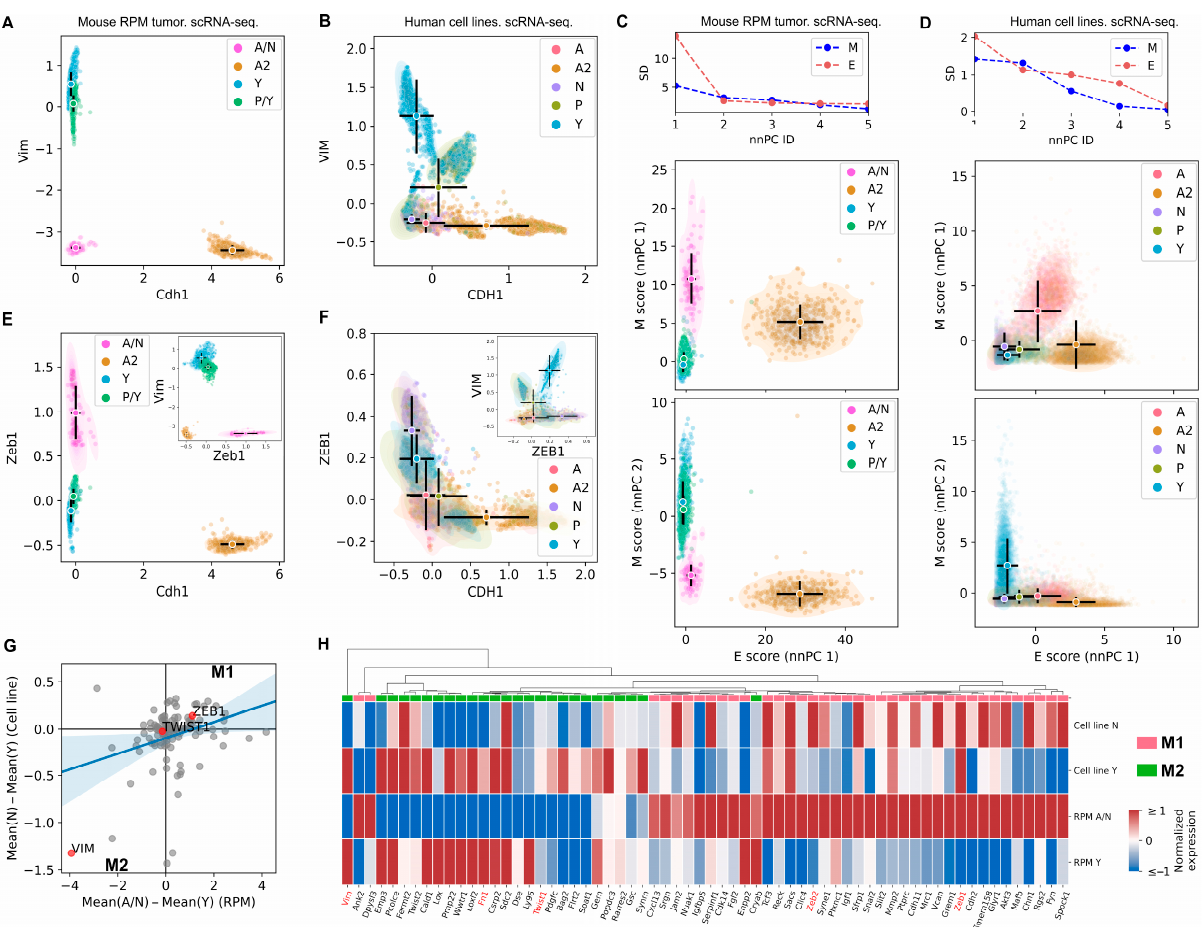
Figure 2. Divergence of mesenchymal gene expressions in SCLC subtypes. ( A , B ) Normalized expression levels of Vim (M gene) and Cdh1 (E gene) in 15,138 mouse Myc -driven tumor cells ( A ) and in 13,945 cells from eight SCLC cell lines ( B ). Imputed data were plotted in B for visual aid. Circles and black bars show means and standard deviations of SCLC subtypes. ( C , D ) Line plots: nnPCA was performed. Plots show standard deviations of SCLC subtype means for mouse and human SCLC cells from the top 5 PCs. Scatter plots: nnPCA-based E and M scores. ( E , F ) Normalized ex- pression levels of Zeb1 (M gene) and Cdh1 (E gene) in 15,138 mouse Myc -driven tumor cells ( E ) and in 13,945 cells from 8 SCLC cell lines ( F ). Imputed data were plotted in F for visual aid. ( G ) Mean differences between N cells (A/N cells for mouse) and Y cells in individual M gene’s expression in mouse and human SCLC cells. ( H ) A heatmap showing the diversity of M gene expression across N (A/N) and Y subtypes. 3.3. The Highly Epithelial A2 Subtype and Diverse M Gene Expression Patterns Are Detectable in Human SCLC Tumor The distinction between the A2 and A subtypes has generally not been considered in previous studies by other investigators. For example, Chan et al. profiled 54,523 individ- ual SCLC cells from 19 human samples and classified them into A, N, and P subtypes (note the absence of the Y subtype) [35]. We therefore asked whether our analytical frame- work can be used to discover previously unknown, extremely epithelial-like cells in this human SCLC tumor dataset. We first performed E and M scoring for this dataset (Figure 3A) and found that A cells (as subtyped in Chan et al. [35]) fell into two distinct groups, one of which was highly E-like (Figure 3B, red arrow). We hypothesized that the cells labeled as A subtype by Chan et al. include both extreme E-like (A2) and EMT-